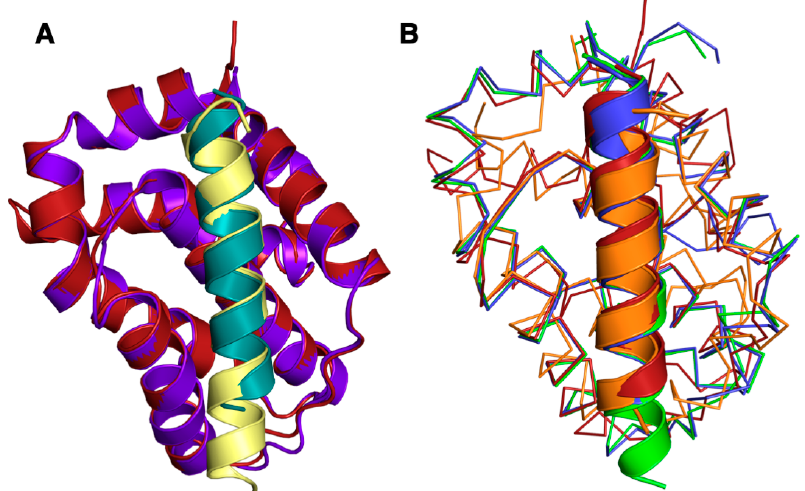
Figure 3. Superimposition of A179L:Beclin with A179L:Bid and other pro-survival Bcl-2:Beclin complexes. ( A ) Cartoon view of A179L (firebrick):Beclin (teal) superimposed with A179L (purple):Bid (yellow) (PDB ID 5UA4). ( B ) A179L:Beclin superimposed with M11:Beclin (orange), Bcl-X L :Beclin (green) and Bcl-2:Beclin (blue). Beclin is shown as cartoon, whereas A179L, Bcl-2, Bcl-x L and M11 backbones are shown as C α trace. The orientation of the traces is identical to Figure 2 and the structures of Bcl-x L :Beclin BH3, Bcl-2:Beclin BH3 and M11 Beclin BH3 were aligned on A179L Beclin BH3 using Coot [50].